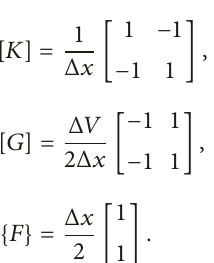
/𝐷 ratio = 5 ). concrete coating